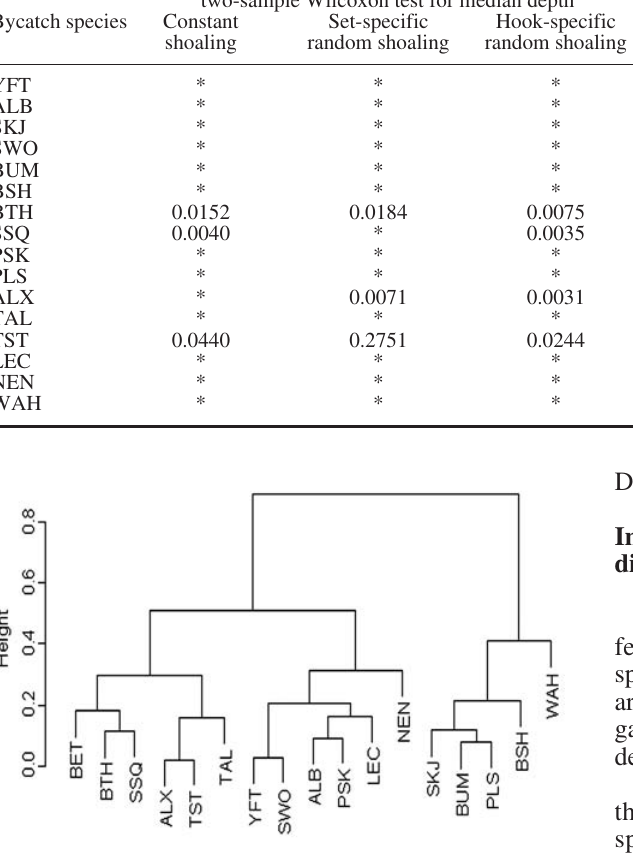
Fig . 4. – Clustering tree for 17 pelagic species captured in the lon- gline observer trip in the central-eastern Pacific Ocean in February- November 2006. The clustering was based on the Euclidean dis- tance in the capture depth among different species. Capture depths were corrected by hook-specific shoaling factors from the uniform distribution U (0.15, 0.25). See Table 1 for full species